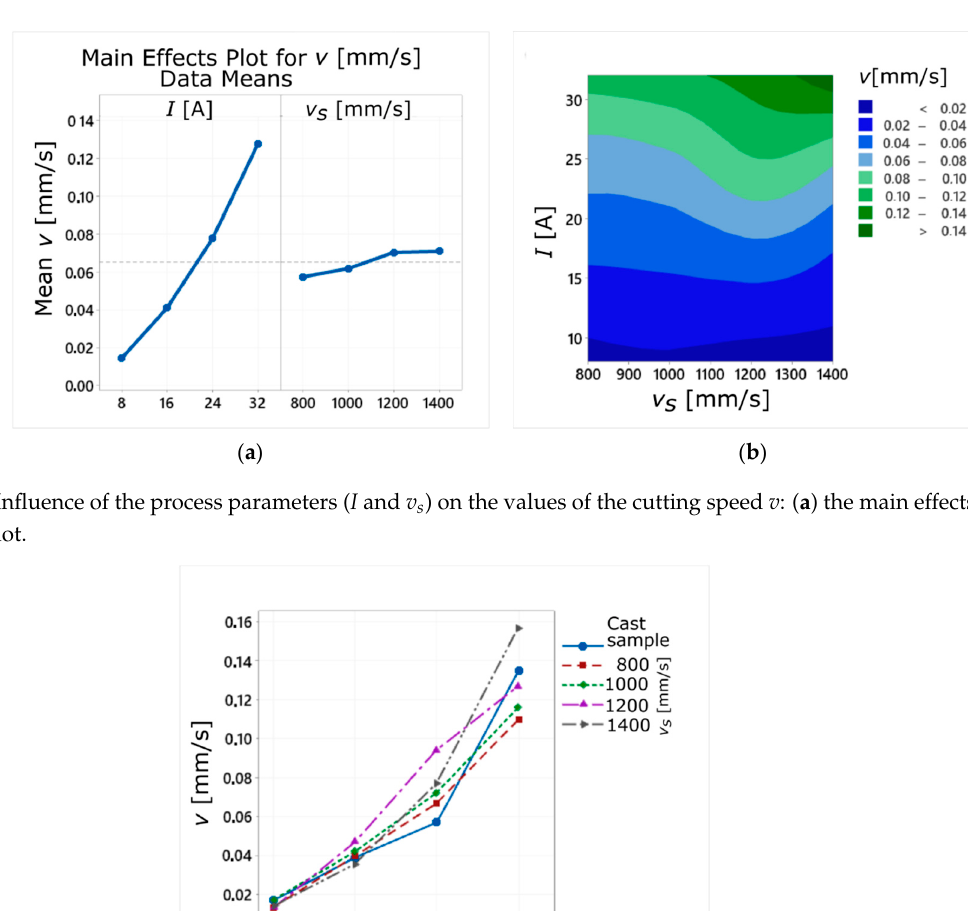
Figure 3. Influence of the process parameters ( I and v s ) on the values of the cutting speed v : ( a ) the main effects’ plot; ( b ) the contour plot.